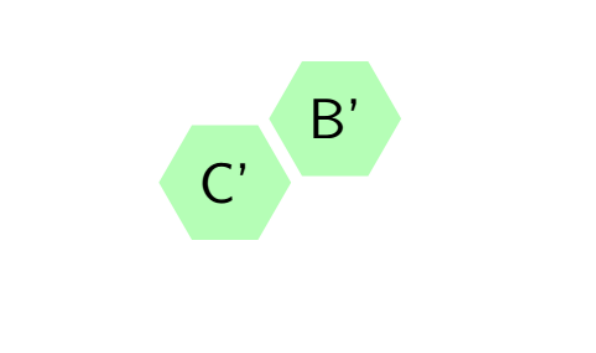
Figure 15. Hexagonal tiling in small complex formed as the result of aggregation symmetric